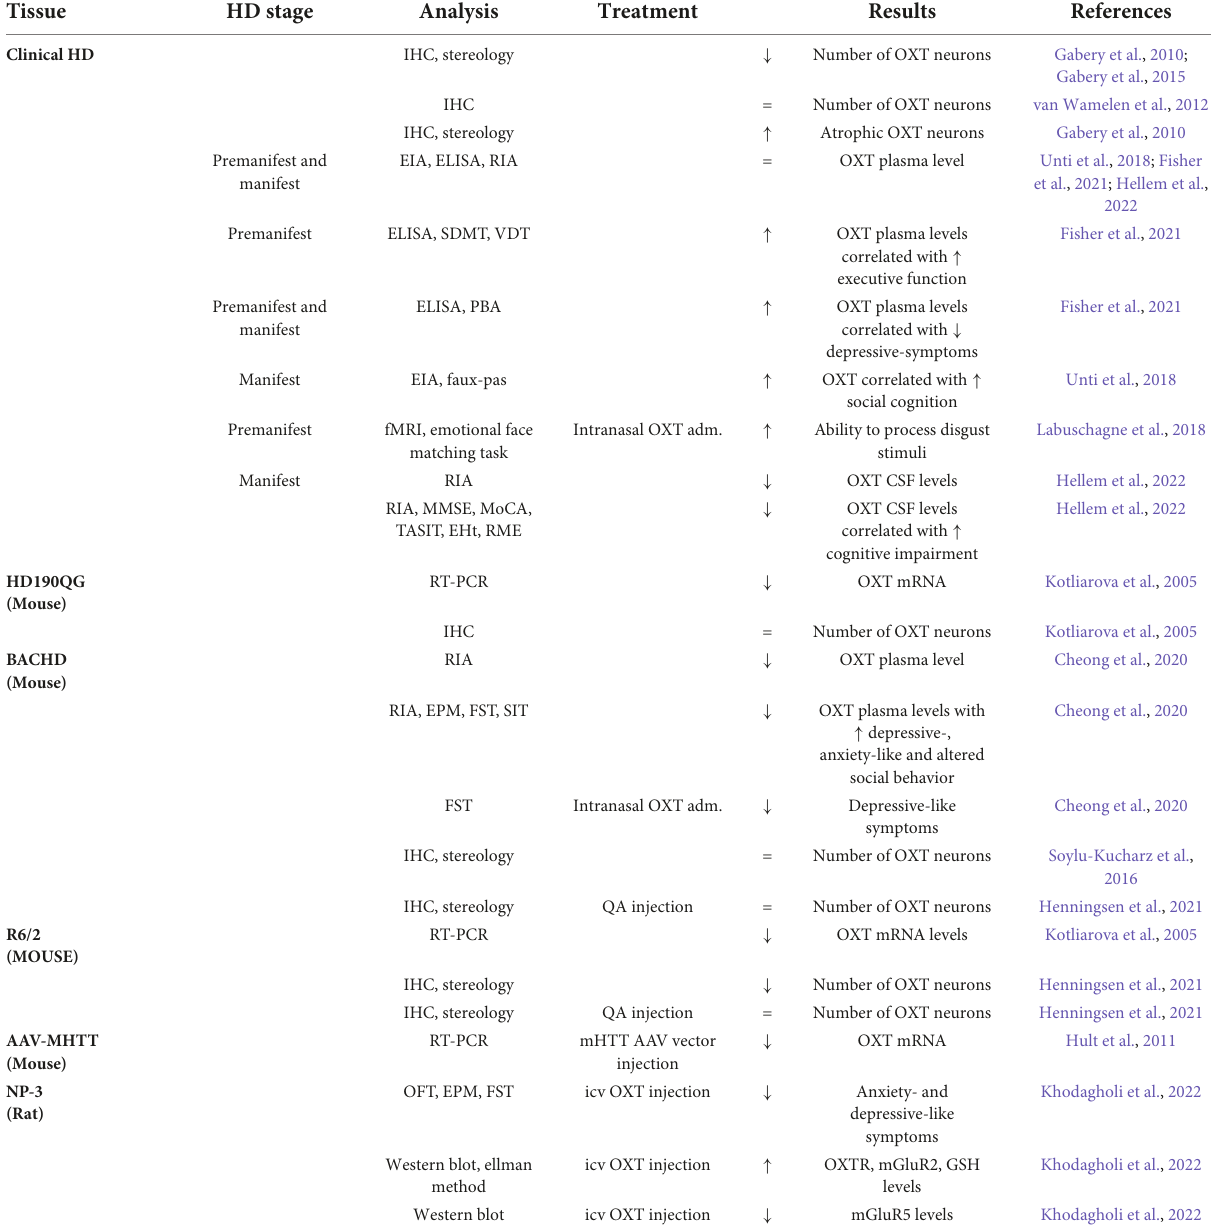
TABLE 1 Summary of oxytocin (OXT) results in Huntington’s disease